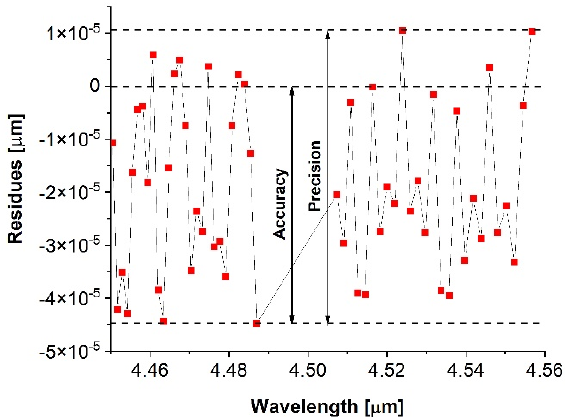
Figure 2. Plot of differences between the centers of the 53 highest N 2 O absorption lines in the range of 4.4–4.7 μ m, determined on the basis of calculations from the HITRAN database and measured with IFS 125HR.